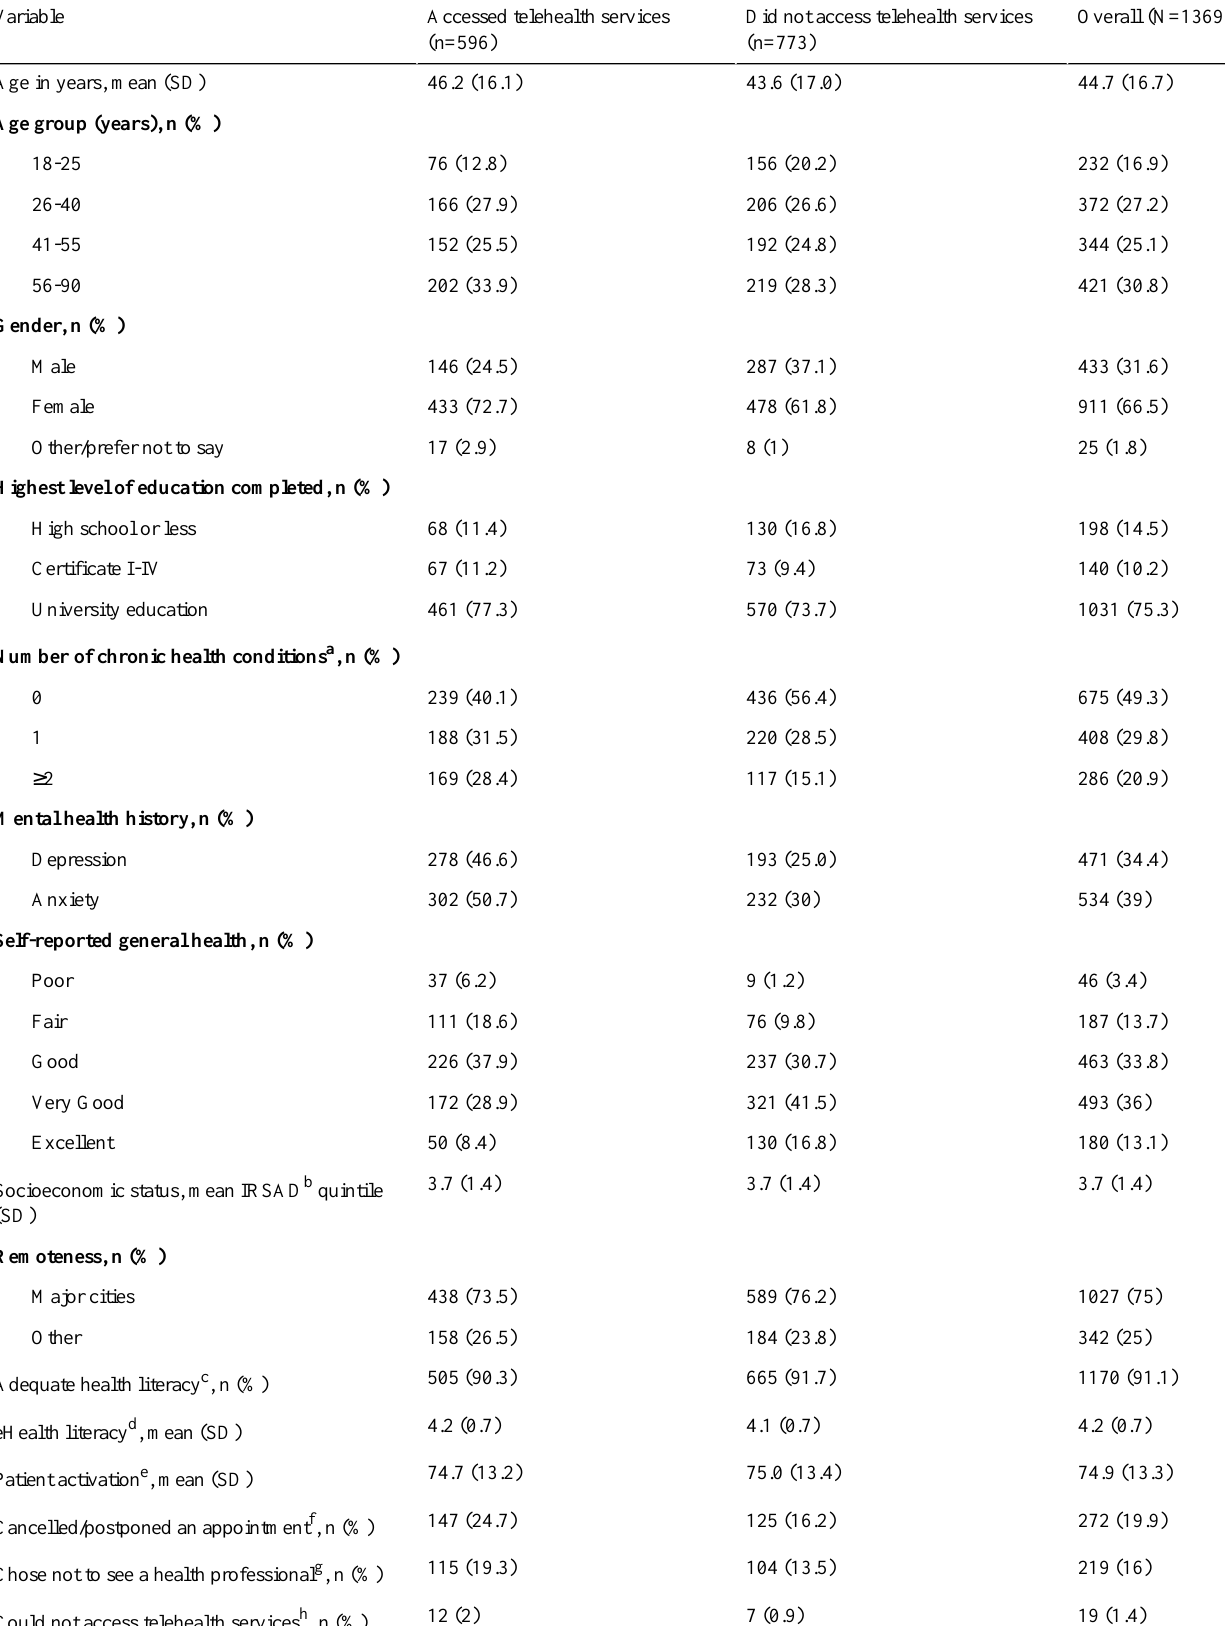
Table 1. Descriptive characteristics of our sample sorted by participants’use of telehealth services during the COVID-19 lockdown period.